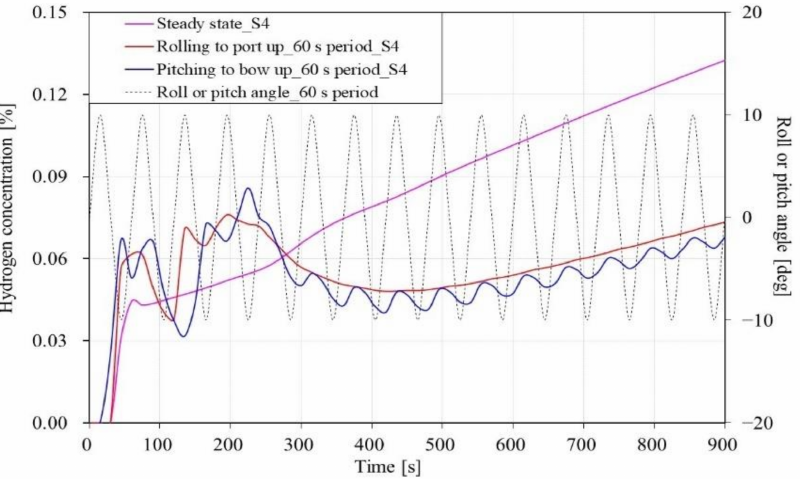
Figure 9. Hydrogen concentration by roll or pitch motion at S4.